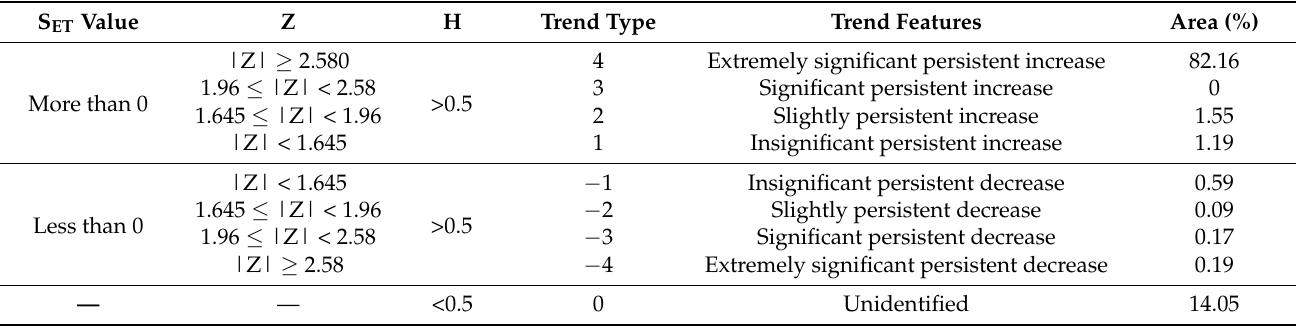
Table 2. Statistics of ET trends and the Hurst index